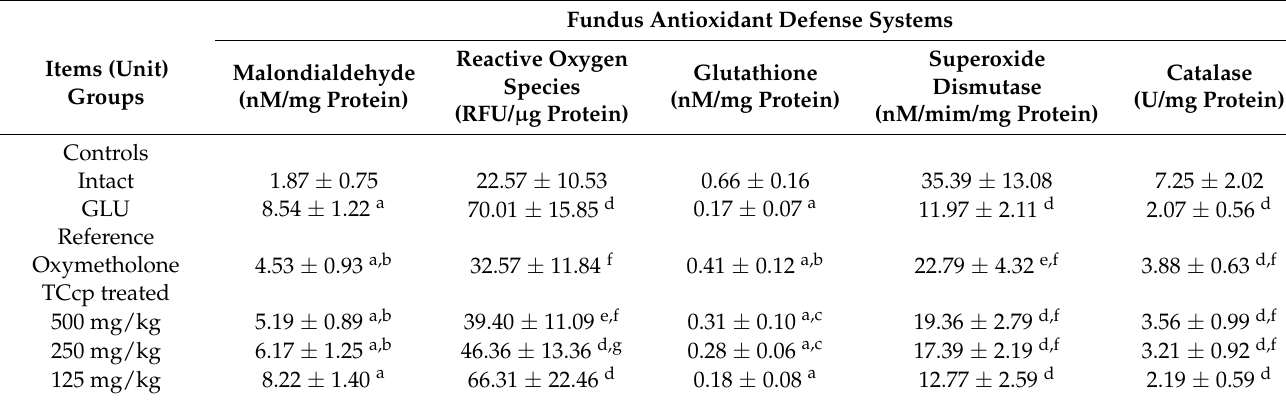
Table 4. Changes in gastrocnemius muscle antioxidant defense